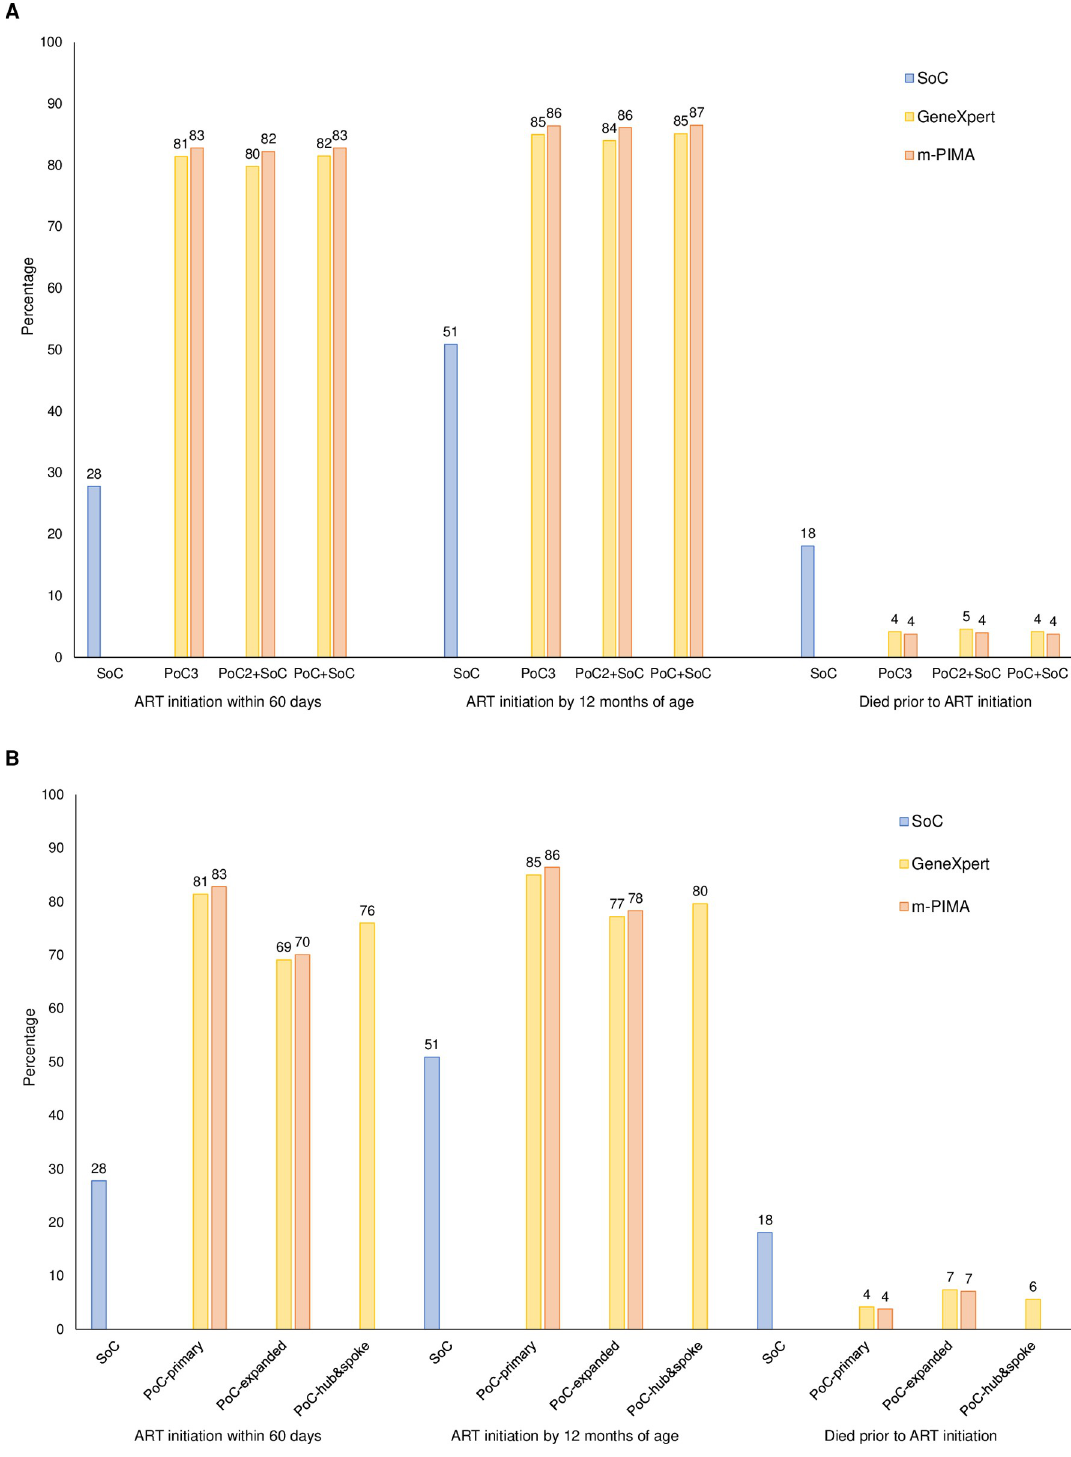
Fig 1. Health outcomes for standard of care and point-of-care testing by (A) testing algorithm and (B) implementation model. ART: antiretroviral therapy; PoC: point-of-care testing; SoC: standard of care testing. Note: (A) testing algorithms are presented for the primary implementation model; (B) implementation models are presented for the PoC3 algorithm.